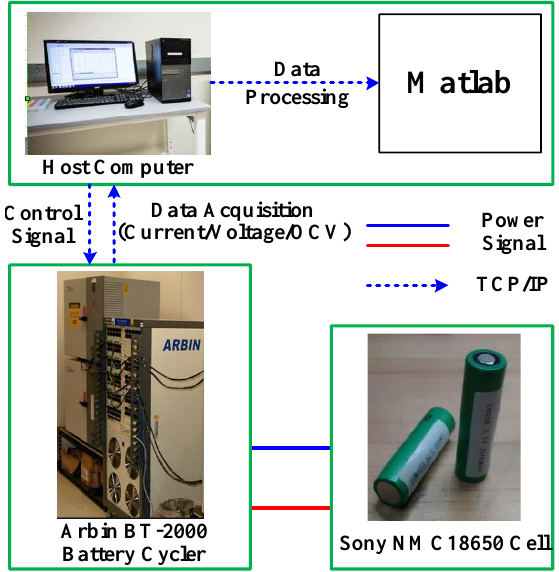
Figure 2. Test configuration of Li-ion battery test bench.